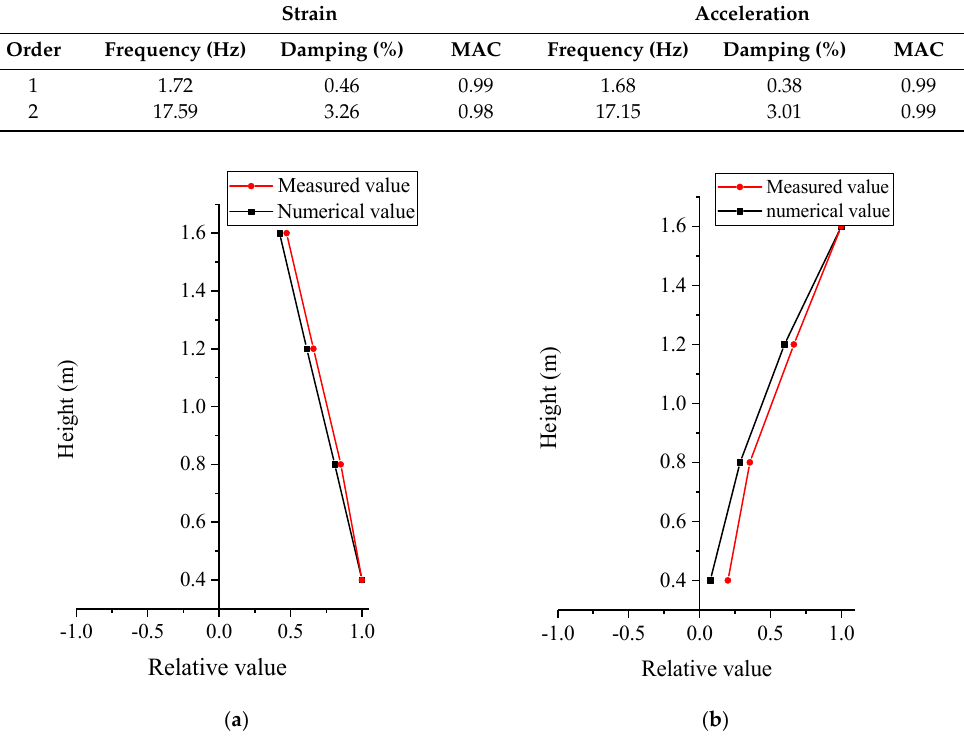
Table 3. Technical parameters of the wind turbine [27].